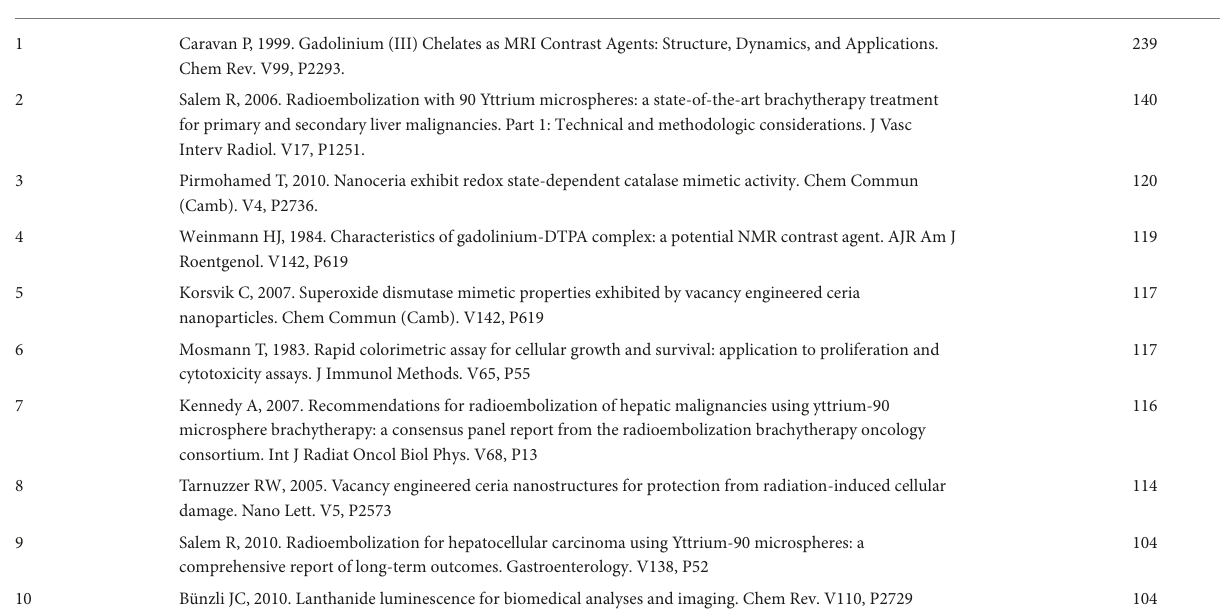
TABLE 6 The top 10 co-cited references in terms of the research on the association of rare earth elements with cancer [n